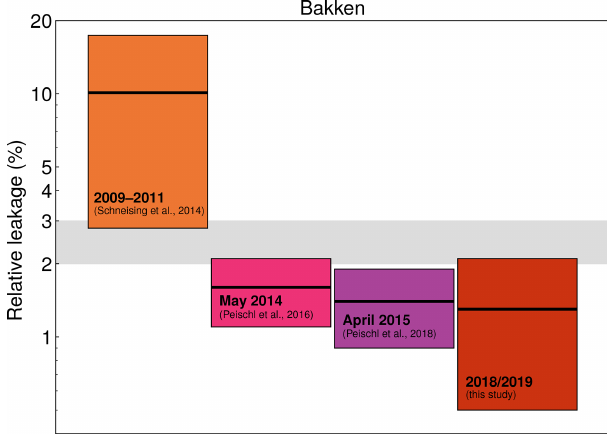
Figure 6. Comparison of fugitive emission rates for the Bakken for- mation from different studies with a reduction of relative leakage over time. See main text for details. The assumed break-even range for immediate climate benefit is shown in